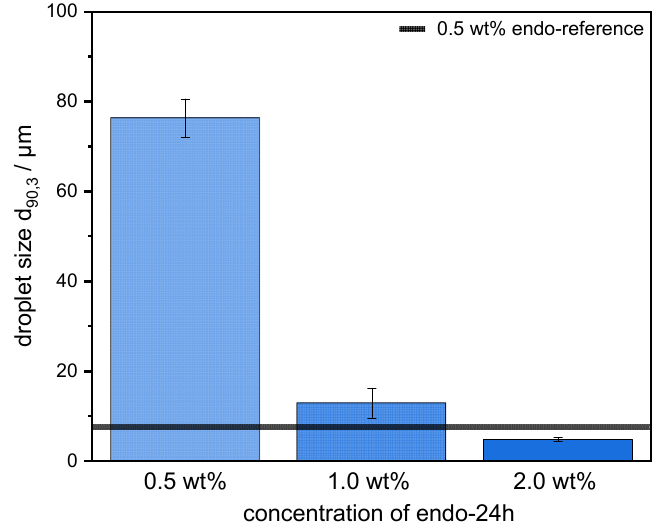
Figure 6. Droplet sizes d 90,3 of emulsions prepared with 0.5 wt%, 1.0 wt%, and 2.0 wt% endo-24h (24 h enzymatic treatment using endo -polygalacturonanase), respectively. A reference line was drawn for 0.5 wt% endo-reference. The emulsions were prepared at pH 3 with 30 wt% mct oil at 400 and 1000 bar.